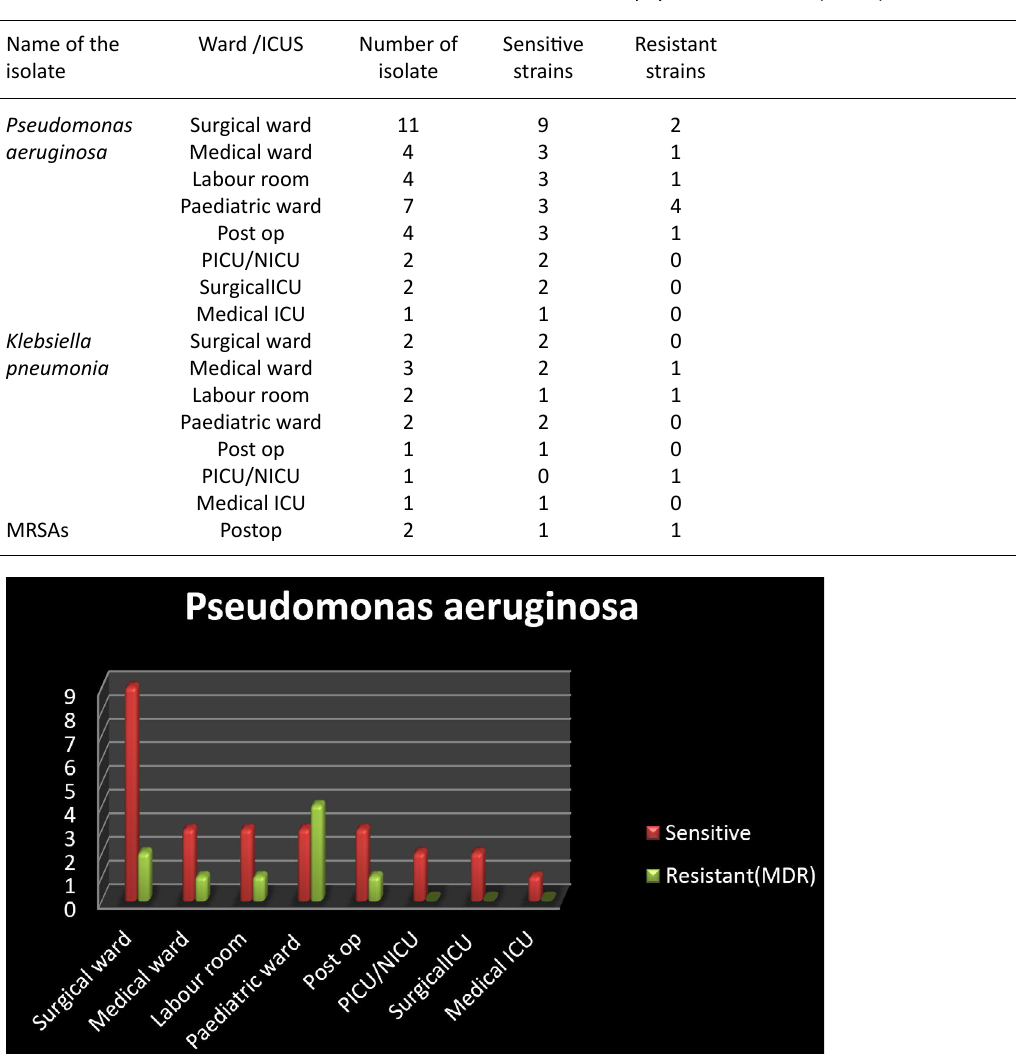
Table 2. Distribution of Resistant strains and Methicillin Resistant Staphylococcus aureus (MRSA)